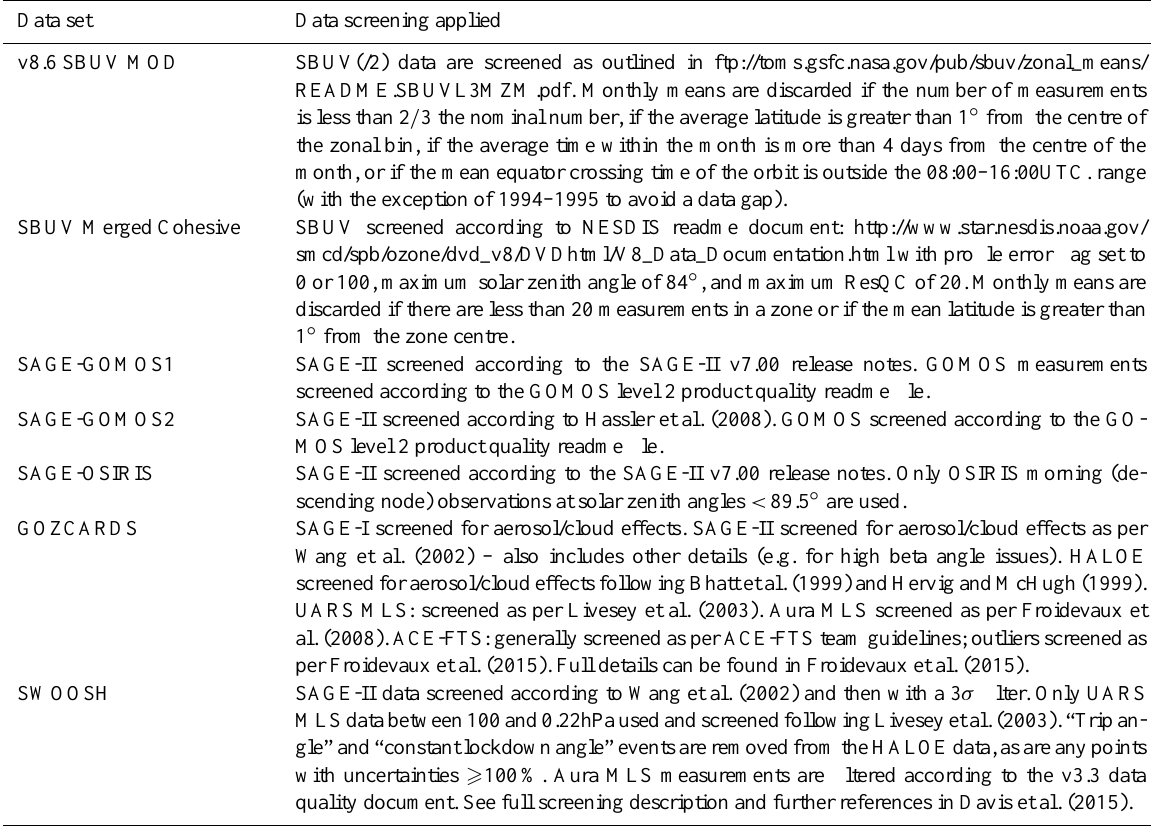
Table 5. Summary of the data screening applied to each of the seven data